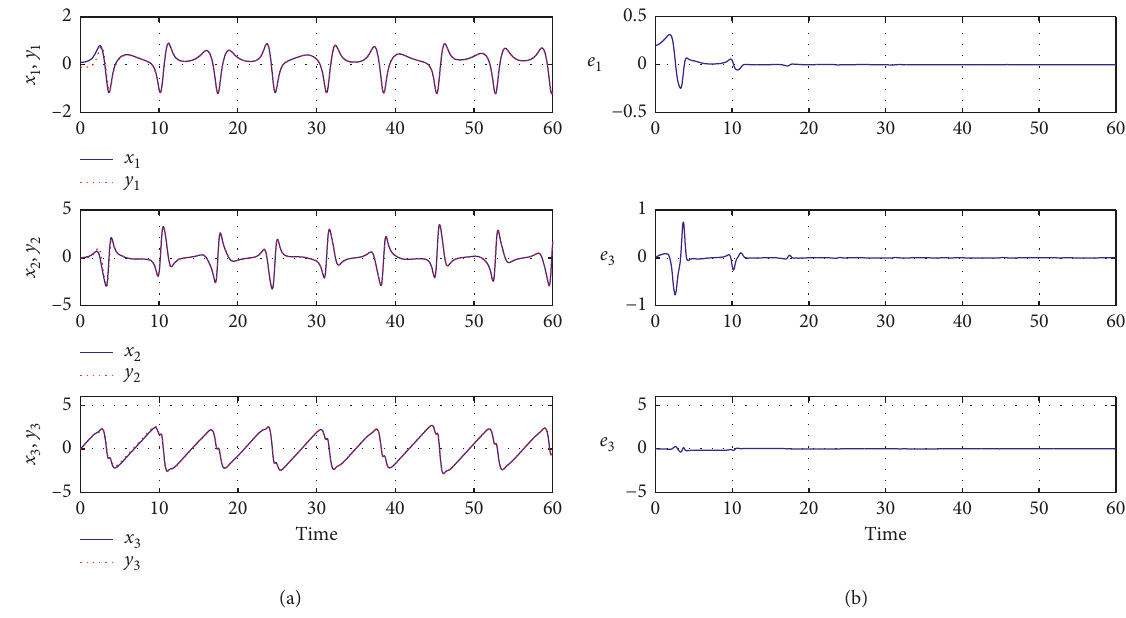
Figure 11: (a) Time response of the states and (b) synchronization error with μ � 3, x ( 0 ) � ( 0 . 1 , 0 , 0 ) and y ( 0 ) � (− 0 . 1 , 0 , 0 )